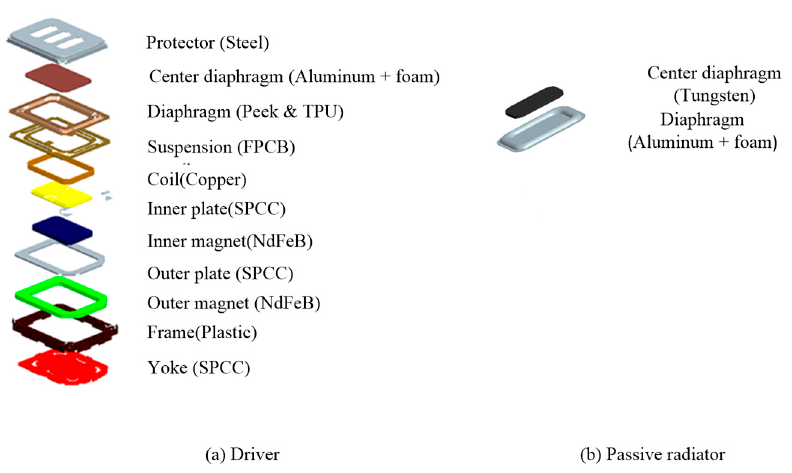
Figure 1. Section view of speaker enclosure with passive radiator.